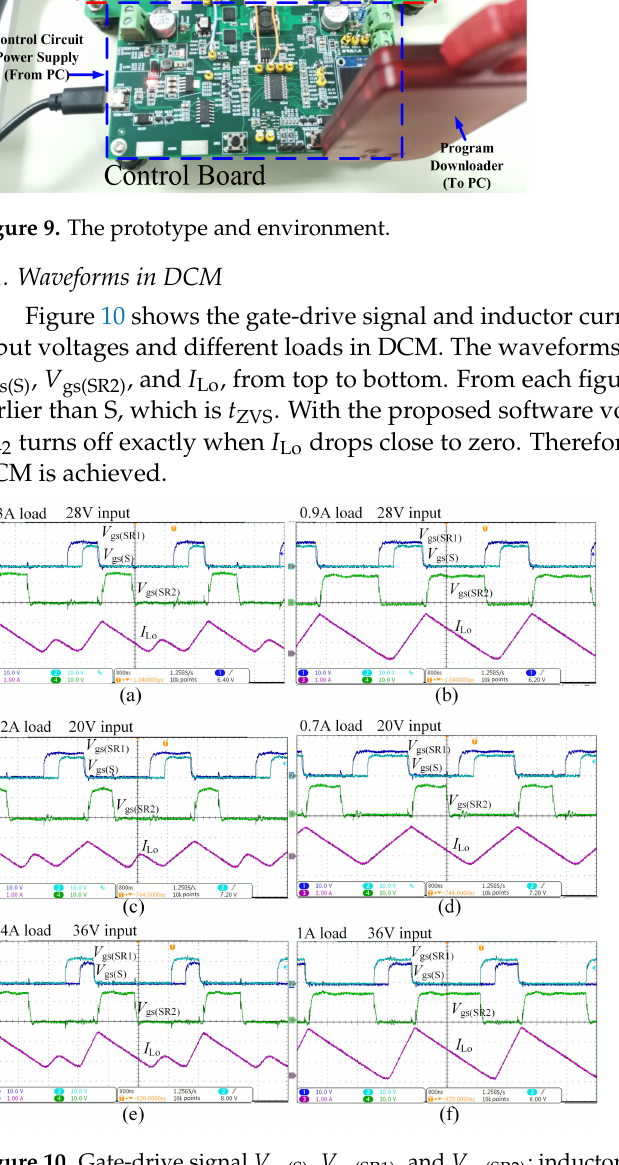
Figure 10. Gate-drive signal V gs(S) , V gs(SR1) , and V gs(SR2) ; inductor current waveforms I Lo at ( a ) 28